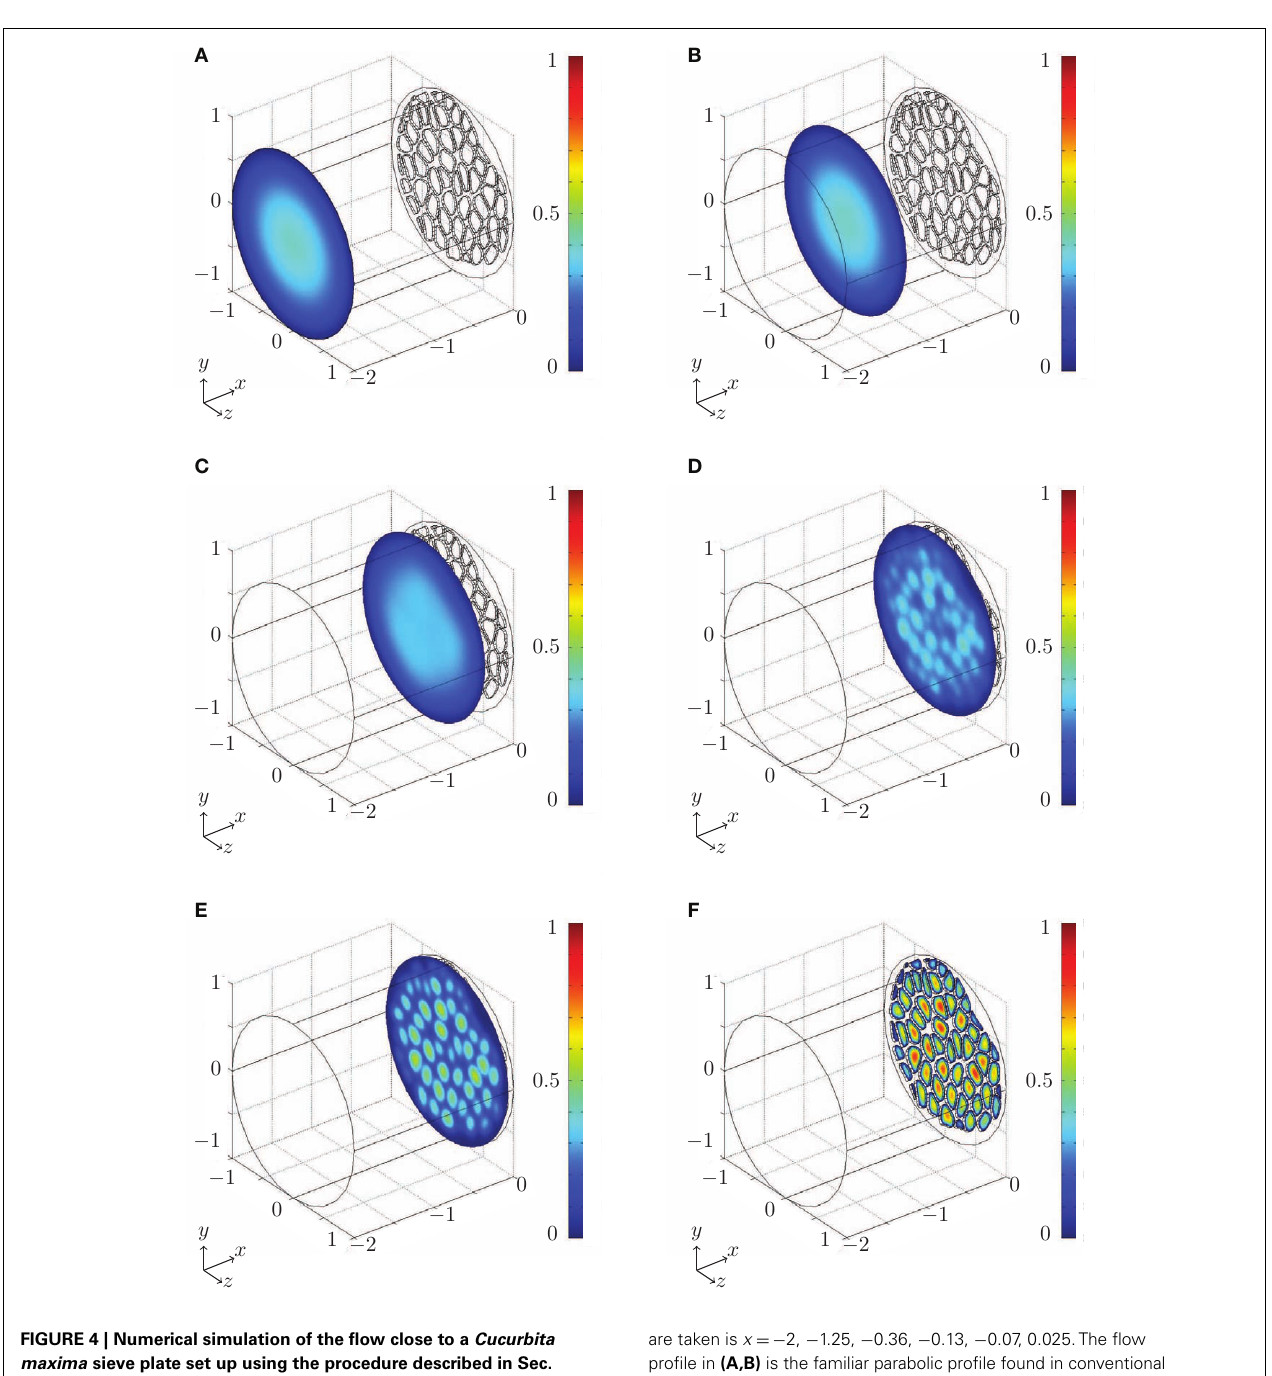
FIGURE 4 | Numerical simulation of the flow close to a Cucurbita maxima sieve plate set up using the procedure described in Sec. 2.3 and Figure 3. Color plot of the magnitude of the flow velocity |u| (from blue = 0 to red = 1 in arbitrary units). The liquid is moving from left to right. In (A–F) , the non-dimensional distance x from the sieve plate (in units of the tube diameter) at which the cross sections